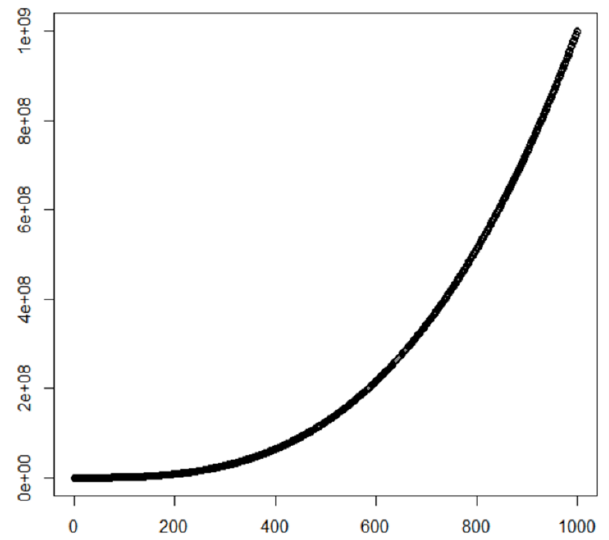
Figure 17. Time complexity of the Floyd–Warshall algorithm using R Studio. (X axis: Number of nodes, Y axis: Amount of calculation).